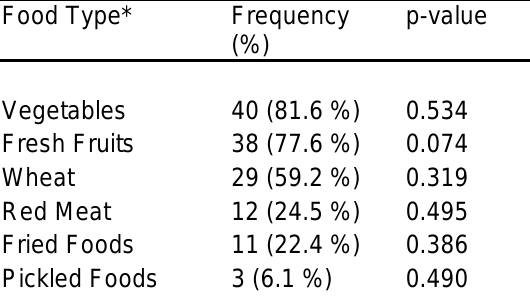
Table 2: Food type consumption